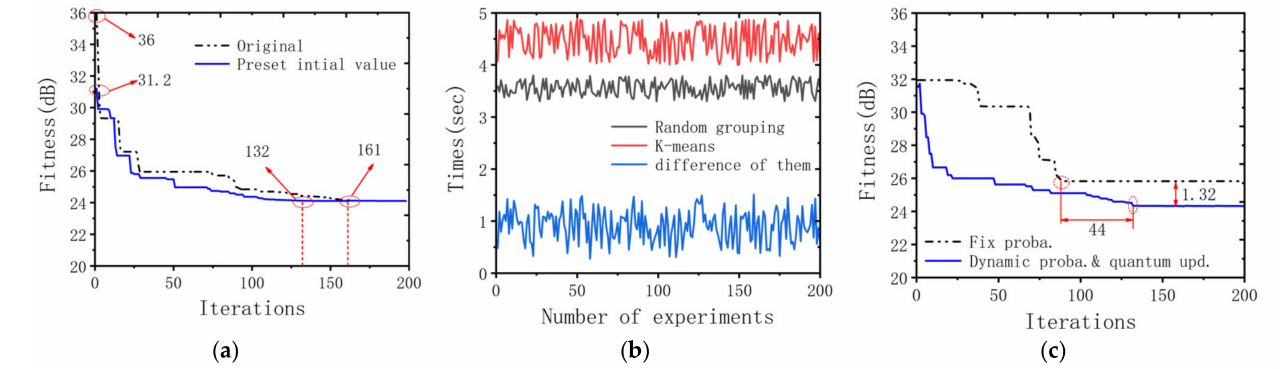
Figure 7. ( a ) Comparison of the fitness value with/without preset initial value. ( b ) The influence curve of grouping method on algorithm running time. ( c ) Comparison of the fitness value of fixed probability and dynamic probability density function and quantum